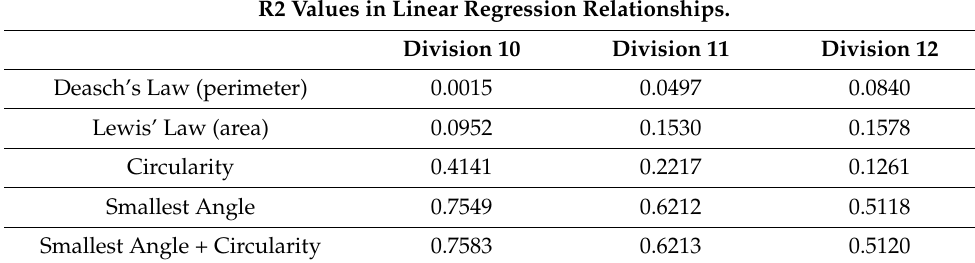
Table 4. Regression analysis of flour beetle cell divisions: 10, 11, and 12. R2 Values in Linear Regression Relationships.